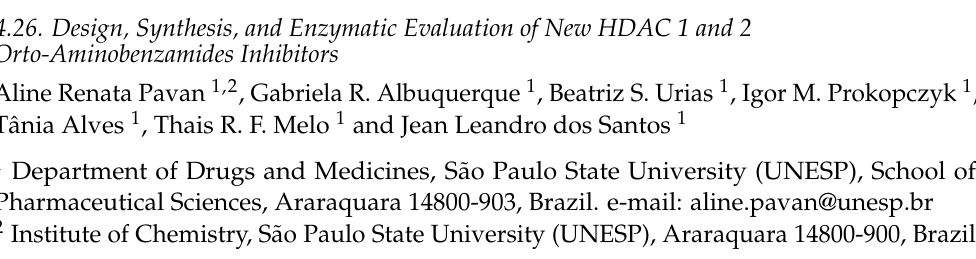
4.26. Design, Synthesis, and Enzymatic Evaluation of New HDAC 1 and 2 Orto-